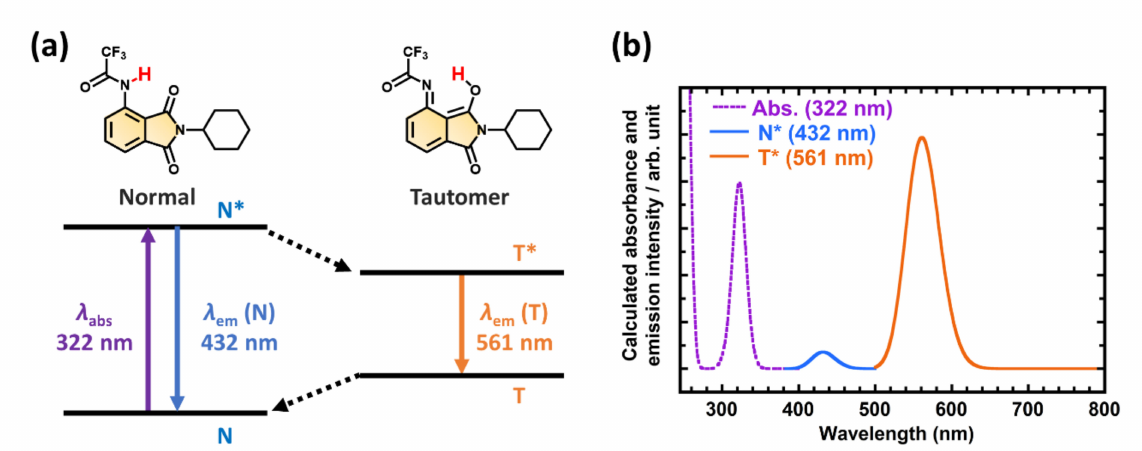
Figure 1. ( a ) Predicted photophysical process of the excited state intramolecular proton transfer (ESIPT) of 3TfAPI. ( b ) Calculated UV-vis absorption (dotted line) and emission (solid line) spectra of 3TfAPI in normal form (N*, blue) and tautomer form (T*, orange), under vacuum.